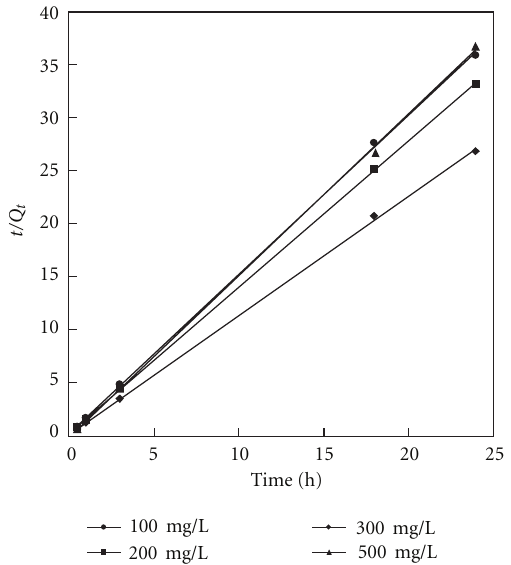
Figure 5: Pseudo-first-order kinetics for adsorption of phenol onto BK at 25 ◦ C.